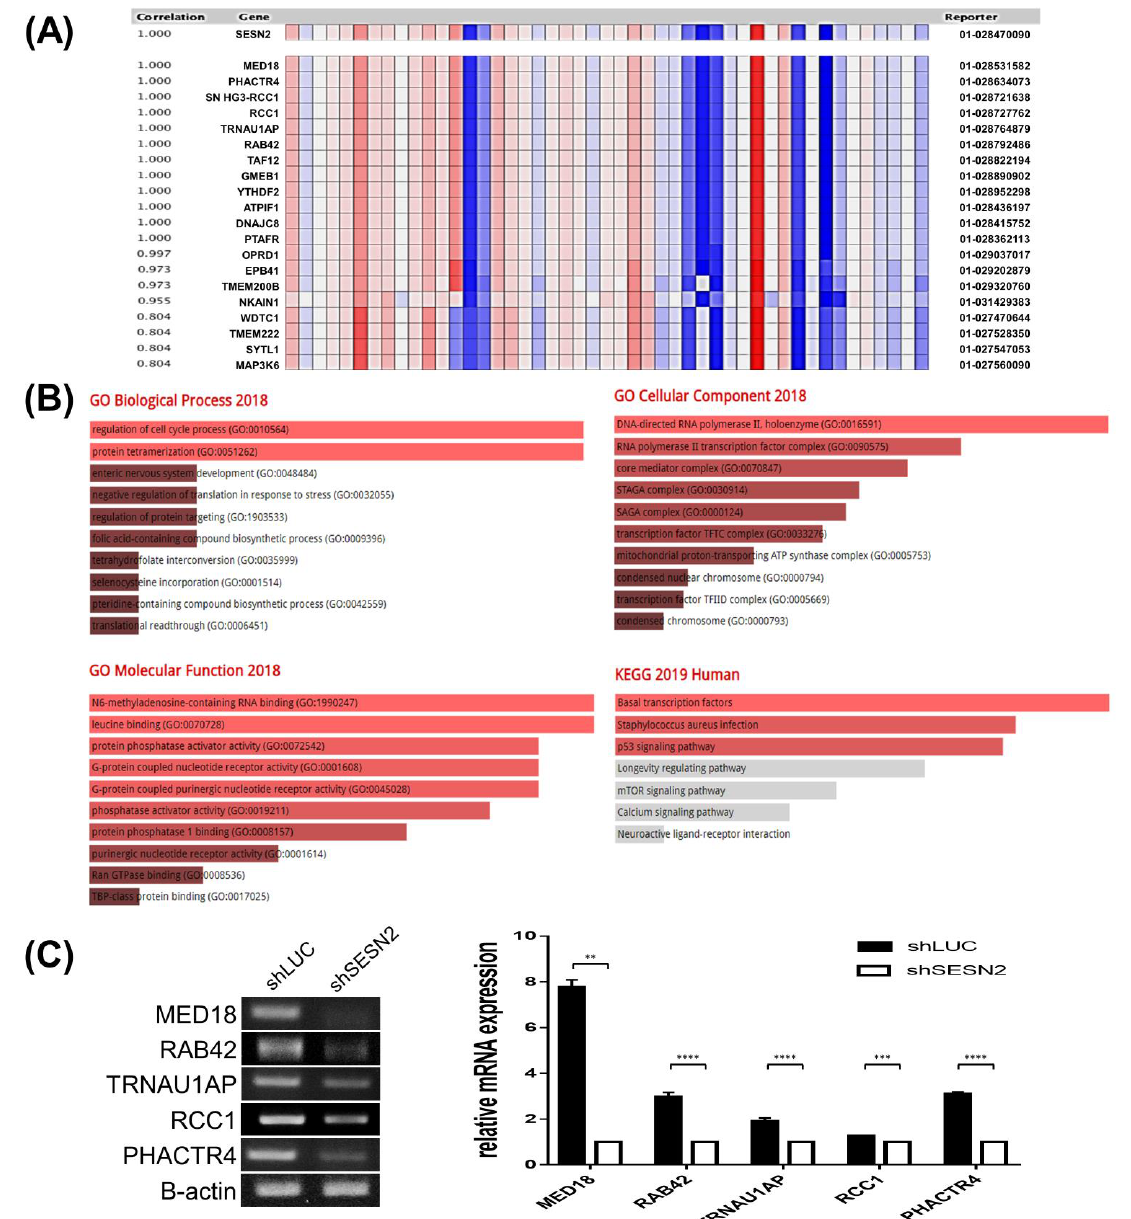
Figure 6. Sestrin2 co-expression gene analysis using RT-PCR ( A ) Co-expression gene analysis in the Bass lung dataset using the Oncomine database. ( B ) GO and KEGG analysis with Sestrin2 and co-expressed genes using Enrichr; bar graph listed by p-value. The brighter the bar color, the more significant the related pathway. ( C ) The expression of top 5 co-expression genes was downregulated in Sestrin2 knockdown A549 cell as shown by RT-PCR. Fold-change was measured by ImageJ; graph shown to the right. (** p < 0.01; *** p < 0.005; **** p < 0.0001).